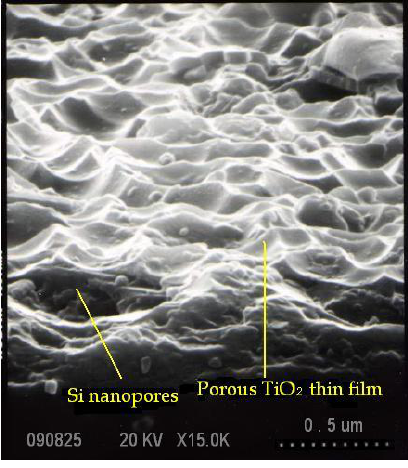
thin film deposited on the silicon 2